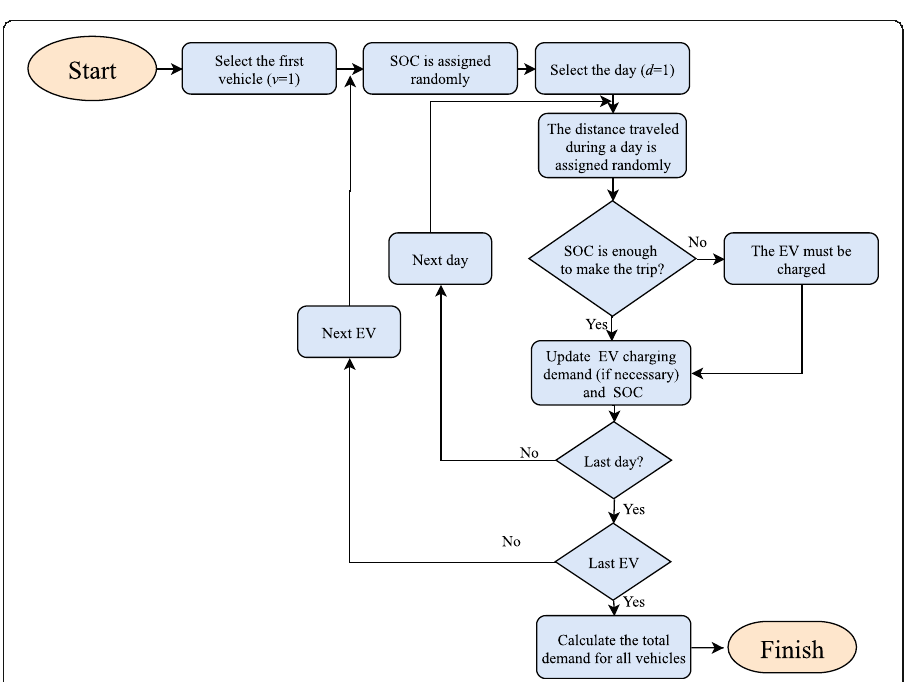
Fig. 3 Flowchart of the proposed method to forecast EVs